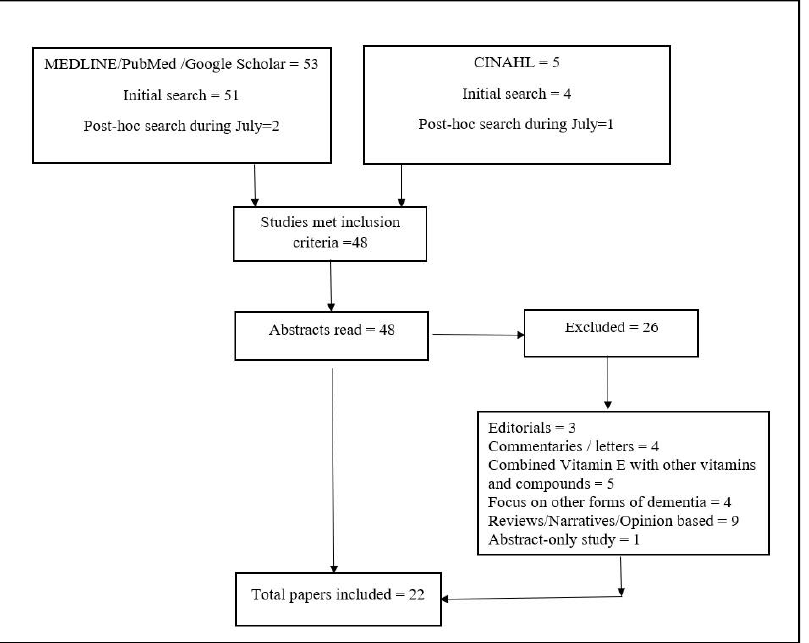
Figure 1. Flow diagram of the literature search and selection process.